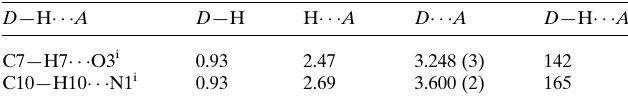
Table 1 Hydrogen-bond geometry (A˚ , (cid:3) ).